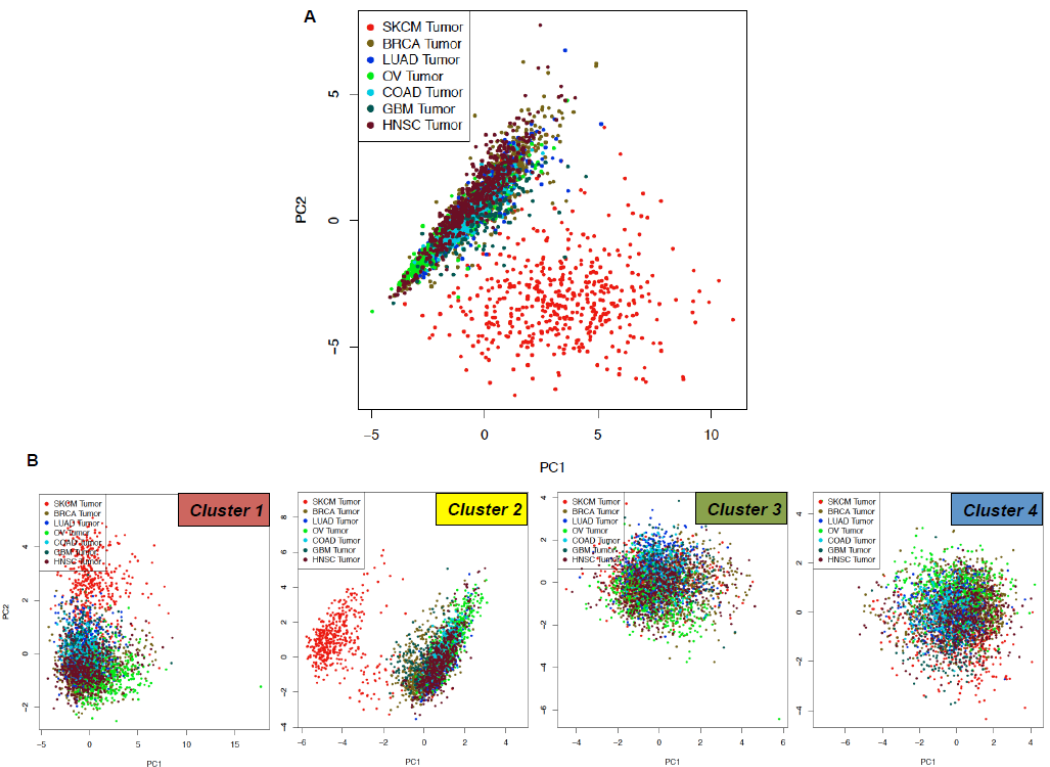
Figure 6. Principal component analyses performed using the expression levels of ( A ) all the 25 genes of “MSCsign” based on The Cancer Genome Atlas (TCGA) data and ( B ) divided according to the four di ff erent clusters identified. SKCM = Skin Cutaneous Melanoma, BRCA = Breast invasive carcinoma, LUAD = Lung adenocarcinoma, OV = Ovarian serous cystadenocarcinoma, COAD = colon adenocarcinoma, GBM = Glioblastoma multiforme, HNSC = Head and Neck squamous cell carcinoma. http: // gepia.cancer-pku.cn /